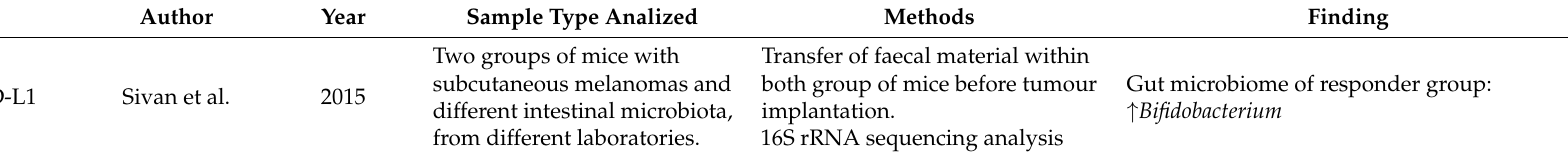
Table 3. Gut microbiota modulation of antitumoural therapies efficacy and